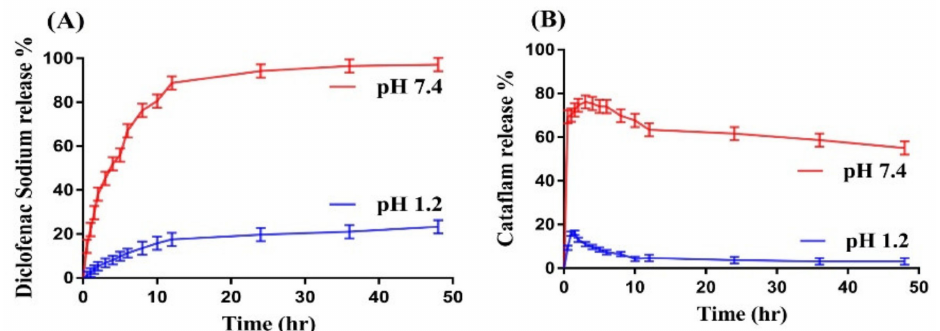
Figure 7. Effect of pH on percent drug release from ( A ) CS/CBP-co-PAA hydrogels and ( B ) commer- cial product